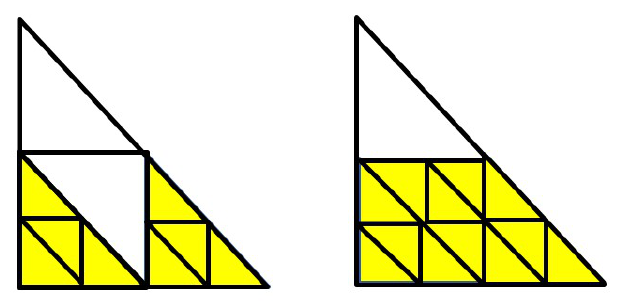
Figure 6. Refinement of infill